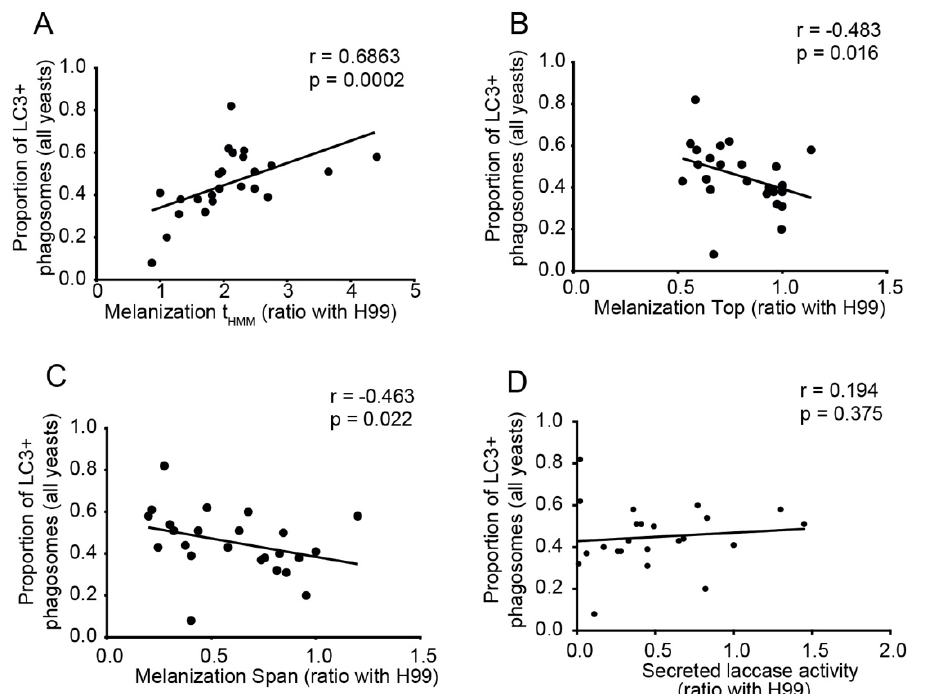
Figure 6. Melanization kinetics affect the ability of clinical isolates to escape from LC3-associated phagocytosis in J774 cells. ( A ) Correlation between LC3-associated phagocytosis with t HMM (represents the speed of melanization index from non-linear regression curve of median gray value), ( B ) with melanization Top (maximum melanization index from non-linear regression curve of median gray value), ( C ) with melanization Span (difference in median gray levels of the colony at the beginning and end of the experiment—difference between top and bottom) and ( D ) no correlation with secreted laccase activity. All correlations were made with Spearman rank ( n = 23).